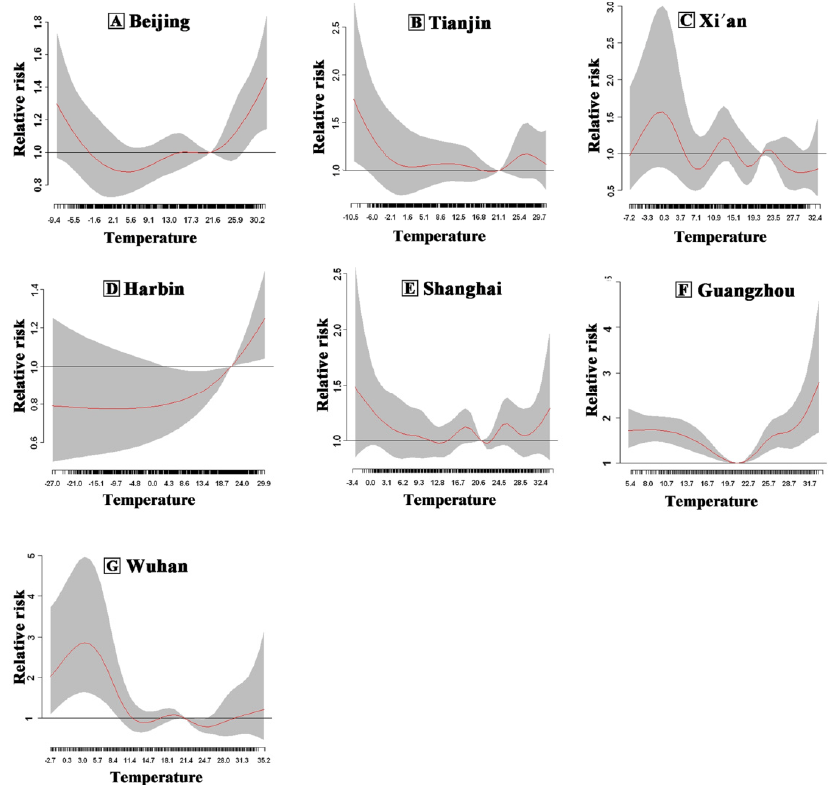
Figure 3. Overall plot of RR along temperature and lags on non-accidental mortality for ( A ) Beijing; ( B ) Tianjin; ( C ) Xi’an; ( D ) Harbin; ( E ) Shanghai; ( F ) Guangzhou and ( G ) Wuhan, China, 2007–2009. The red solid lines represent the estimated relative risk in daily non-accidental mortality and dash areas represent the 95% confidence interval for each estimate.